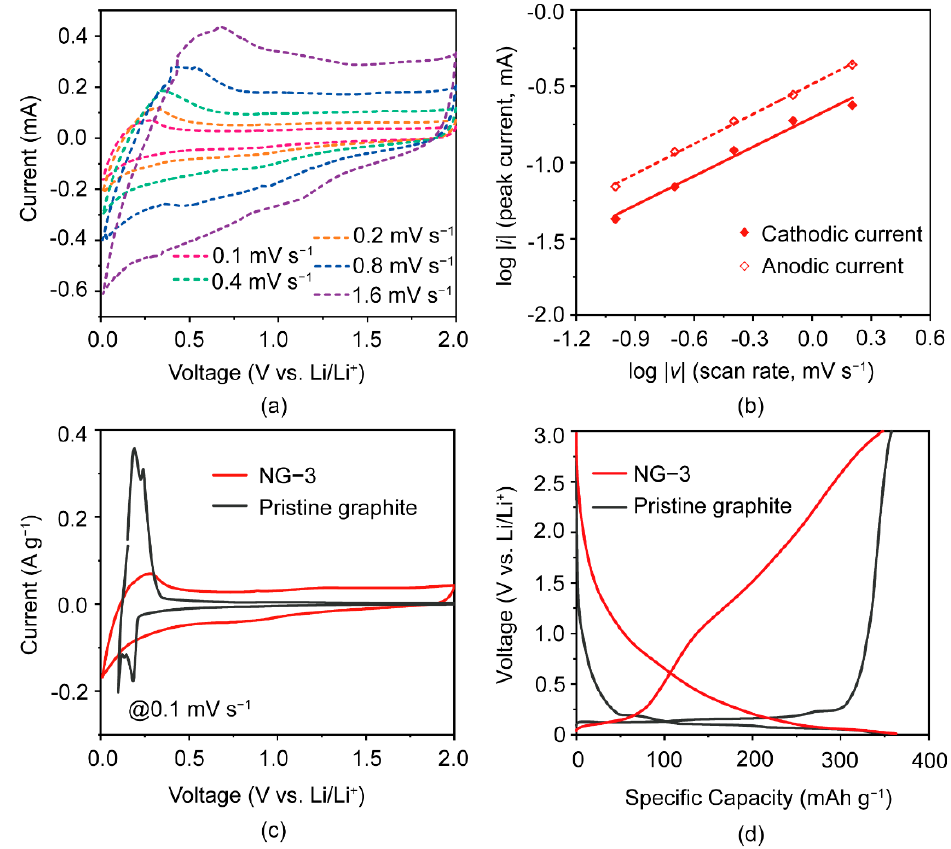
Figure 5. ( a ) Cyclic voltammetry curves of NG-3 electrode at a scan rate ranging from 0.1 to 1.6 mV s − 1 . ( b ) Log|v| − log|i| plot to determine b value based on its slope. ( c ) Cyclic voltammetry curves of NG-3 and natural graphite electrode at a scan rate of 0.1 mV s − 1 . ( d ) Galvanostatic lithiation/delithiation profiles of NG-3 and natural graphite electrode at current density of 0.1 C.